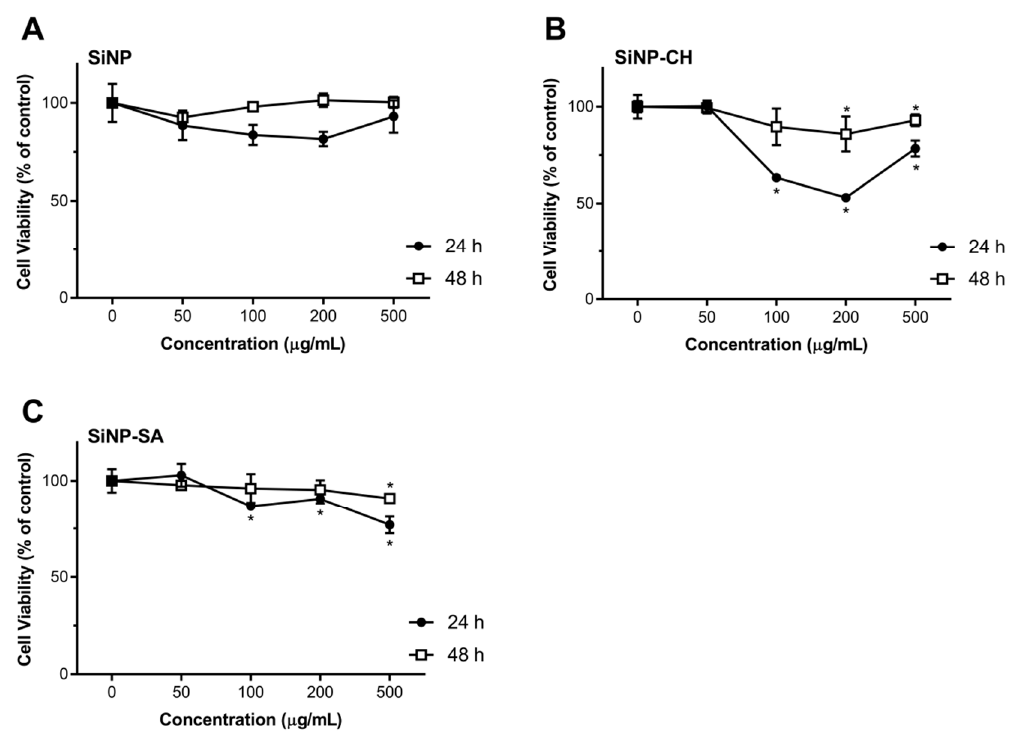
Figure 5. Effect of uncoated and coated SiNP on viability of HepG2 cells after 24 or 48 h exposure to 50, 100, 200 and 500 µg/mL of SiNP ( A ), SiNP-CH ( B ) and SiNP-CH ( C ) Cell viability is expressed as % of control (n = 8) and data are presented as means ± SD. Statistical difference between control group and formulations is reported as * p ˂ 0.05.